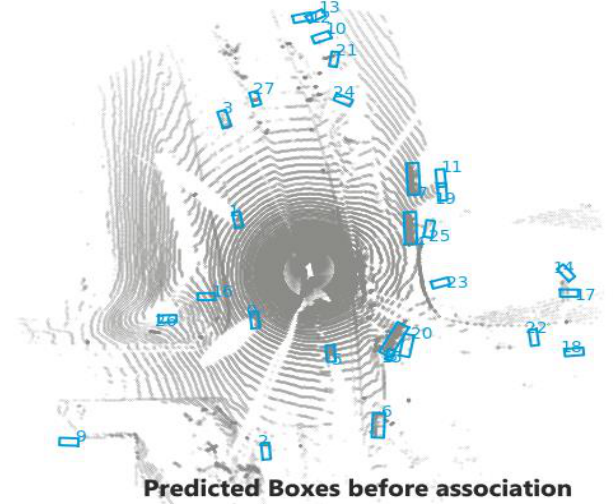
Figure 3. Vehicle tracklets bounding boxes.